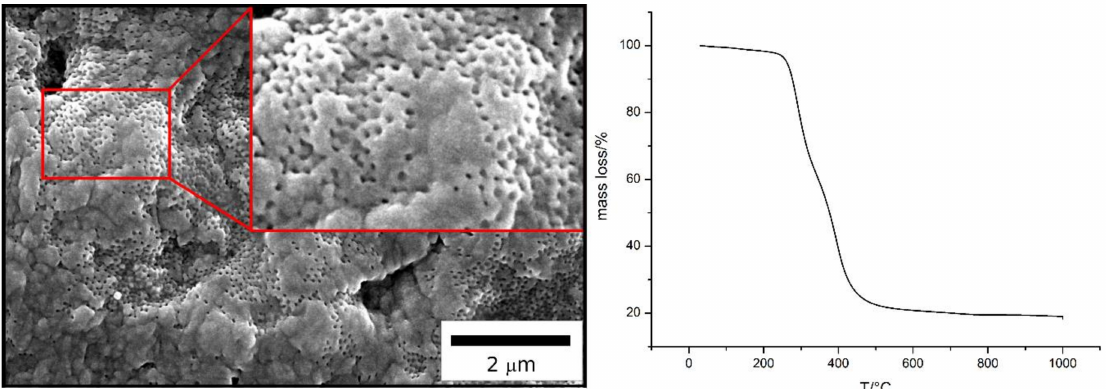
SEM photograph of the cross-section of a porous SiCN film after melt-shearing and ceramization of core / shell particles processed by emulsion polymerization and ATRP. Degradation of the polymer cores starts at ca. 200 ◦ C, ceramic yield amounts to 18